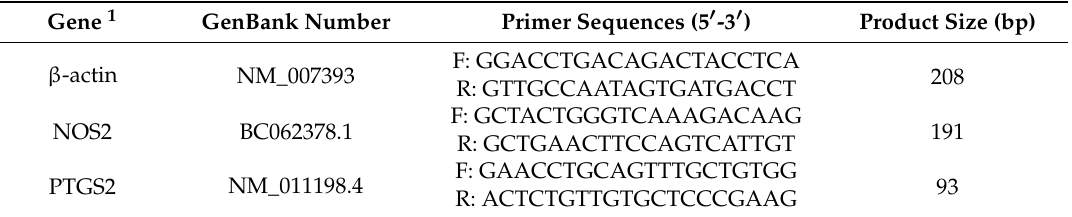
Table 3. Primers for quantitative reverse transcriptase polymerase chain reaction